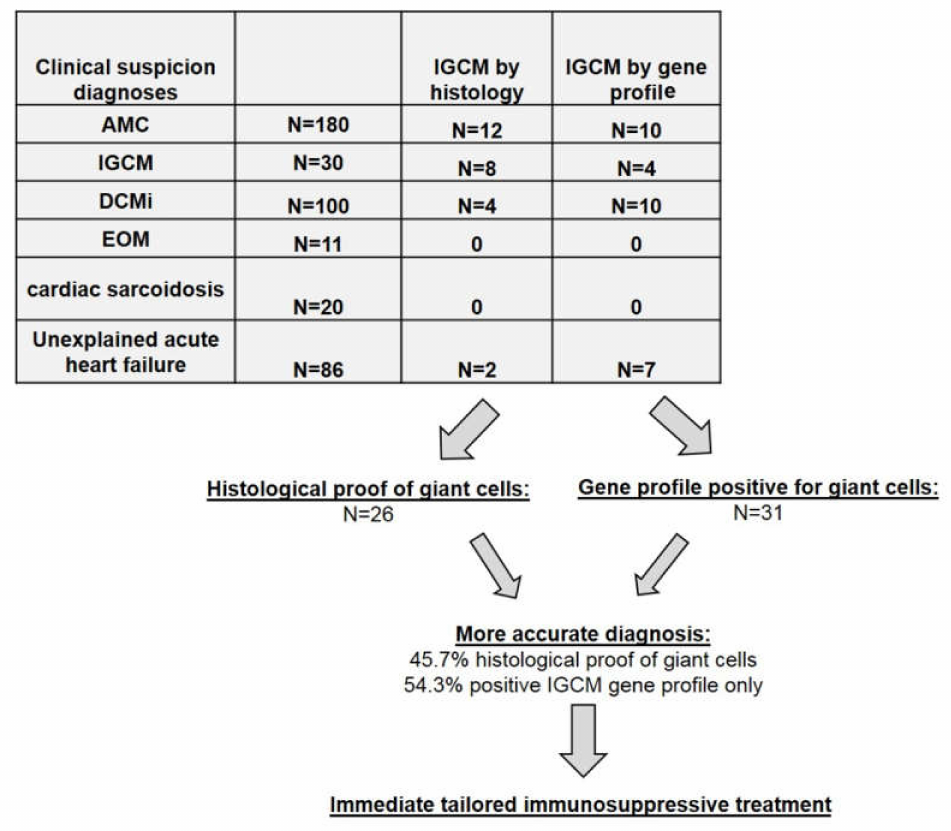
Figure3. ClinicallySuspectedDiagnosesandIGCMHistologicallyProvenorDetectedbyGene-Profiling. Note: AMC = acutemyocarditis; IGCM = idiopathicgiantcellmyocarditis; DCMi = dilatedinflammatory cardiomyopathy; EOM = eosinophilic